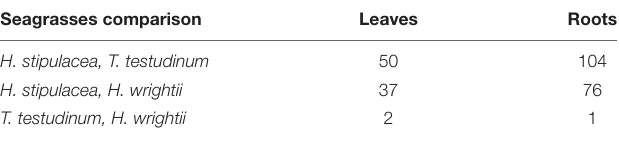
Halophila stipulacea , Halodule wrightii , and Thalassia testudinum . Seagrasses comparison Leaves